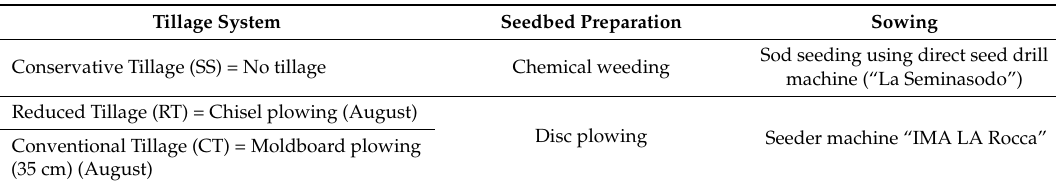
Tillage systems and related seedbed preparation and sowing systems used in the experimental field. Tillage System Seedbed Preparation Sowing Conservative Tillage (SS) = No tillage Chemical weeding Disc